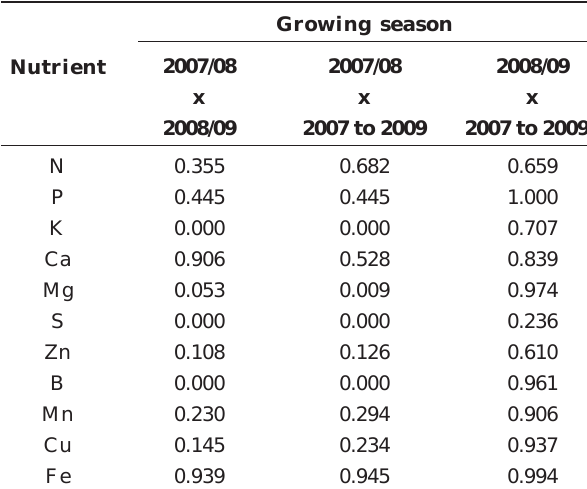
Table 3. Chi-square test with frequency of events interpreted according to the potential response to fertilization proposed by Wadt (1996), taking into account the DRIS indices of each nutrient, calculated using the proposed norms in different growing